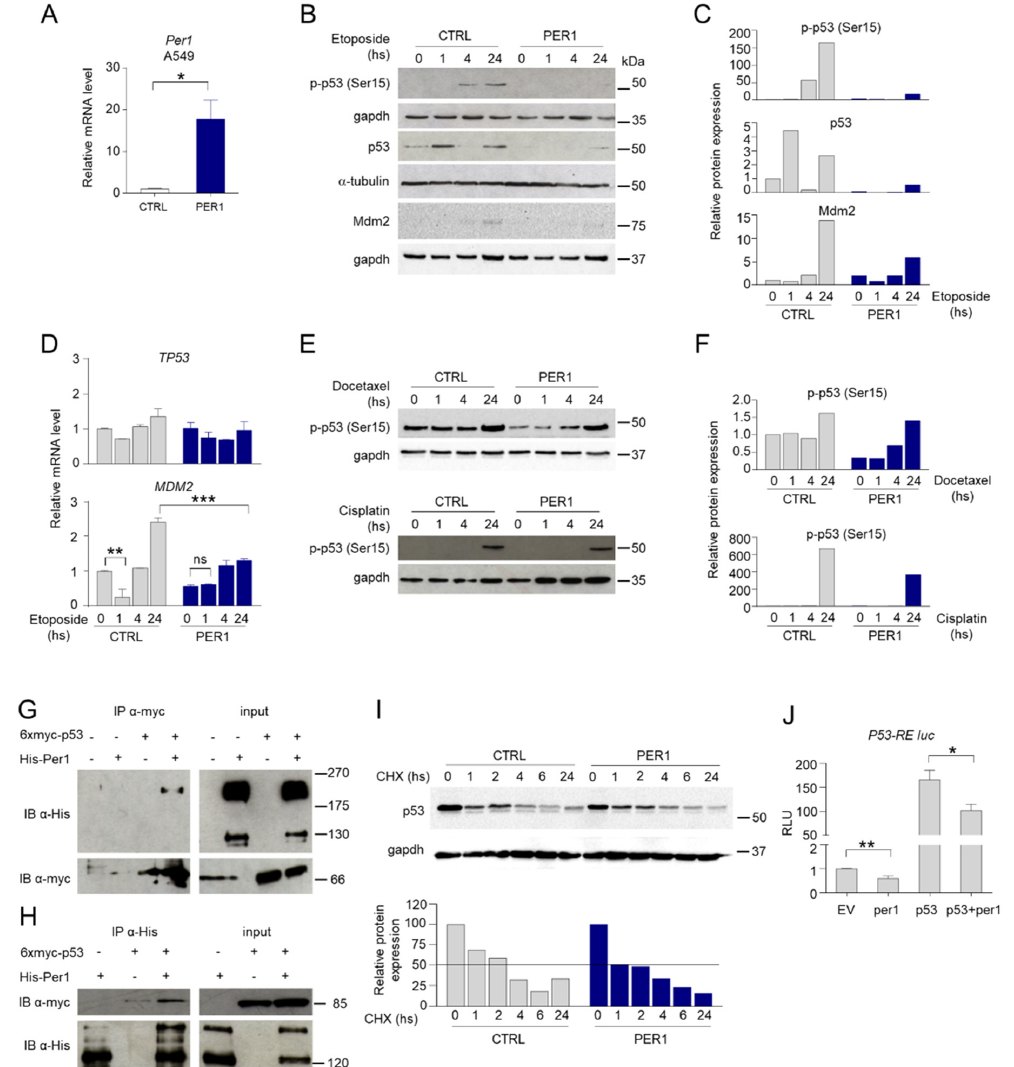
Figure 1. PER1 modulation of p53 expression and activity. ( A ) Control of PER1-overexpressing clones in A549 cells, evaluated by qPCR. A549 cells were transfected with PER1 or a control plasmid (CTRL, pEGFP N1) and positive clones were selected with G418 treatment. Bars represent average ± SD (n = 2). (*) p < 0.05. ( B ) Levels of p-p53 (Ser15), total p53 and Mdm2 following treatment with etoposide for the indicated time in A549 cells stably overexpressing PER1 or CTRL vector, evaluated by Western blotting (WB). Gapdh and α -tubulin were used as loading controls. ( C ) Densitometry for p-p53 (Ser15), total p53 and Mdm2 expression levels relative to (B). ( D ) TP53 and MDM2 gene expression levels in A549 cells stably overexpressing PER1 or CTRL vector treated as in 2B. Bars represent average ± SD (n = 2). (**) p < 0.01, (***) p < 0.001. ( E ) Levels of p-p53 (Ser15) following treatment with docetaxel or cisplatin for the indicated time in A549 cells stably overexpressing PER1 or CTRL vector, evaluated by WB. Gapdh was used as loading controls. ( F ) Densitometry for p-p53 (Ser15) expression levels relative to (E). ( G – H ) Immunoprecipitation (IP) between PER1 and p53. HEK-293 cells were cotransfected with myc-p53 and His-PER1. In (G) p53 was immunoprecipitated with anti-myc antibody. In (H) PER1 was immunoprecipitated with anti-His antibody. Co-immunoprecipitated proteins and total cell lysate (input) were analyzed by WB and revealed with anti-His and anti-myc antibodies. ( I ) Expression of p53 in A549 cells overexpressing PER1 or a control plasmid (CTRL) and treated with cycloheximide (CHX, 100 μ M) for the indicated times. Gapdh was used as loading control. Densitometry for p53 expression levels is shown on the bottom. ( J ) Evaluation of the activation of p53-RE-Luc by luciferase assay in HEK-293 cells transfected with the indicated plasmids (ev = empty vector). Levels of expression are relative to the control transfected with empty vector, after normalization for transfection efficiency through beta-galattosidase assay. Bars represent average of RLU (relative luciferase units) ± SD (n = 3). (*) p < 0.05, (**) p < 0.01.